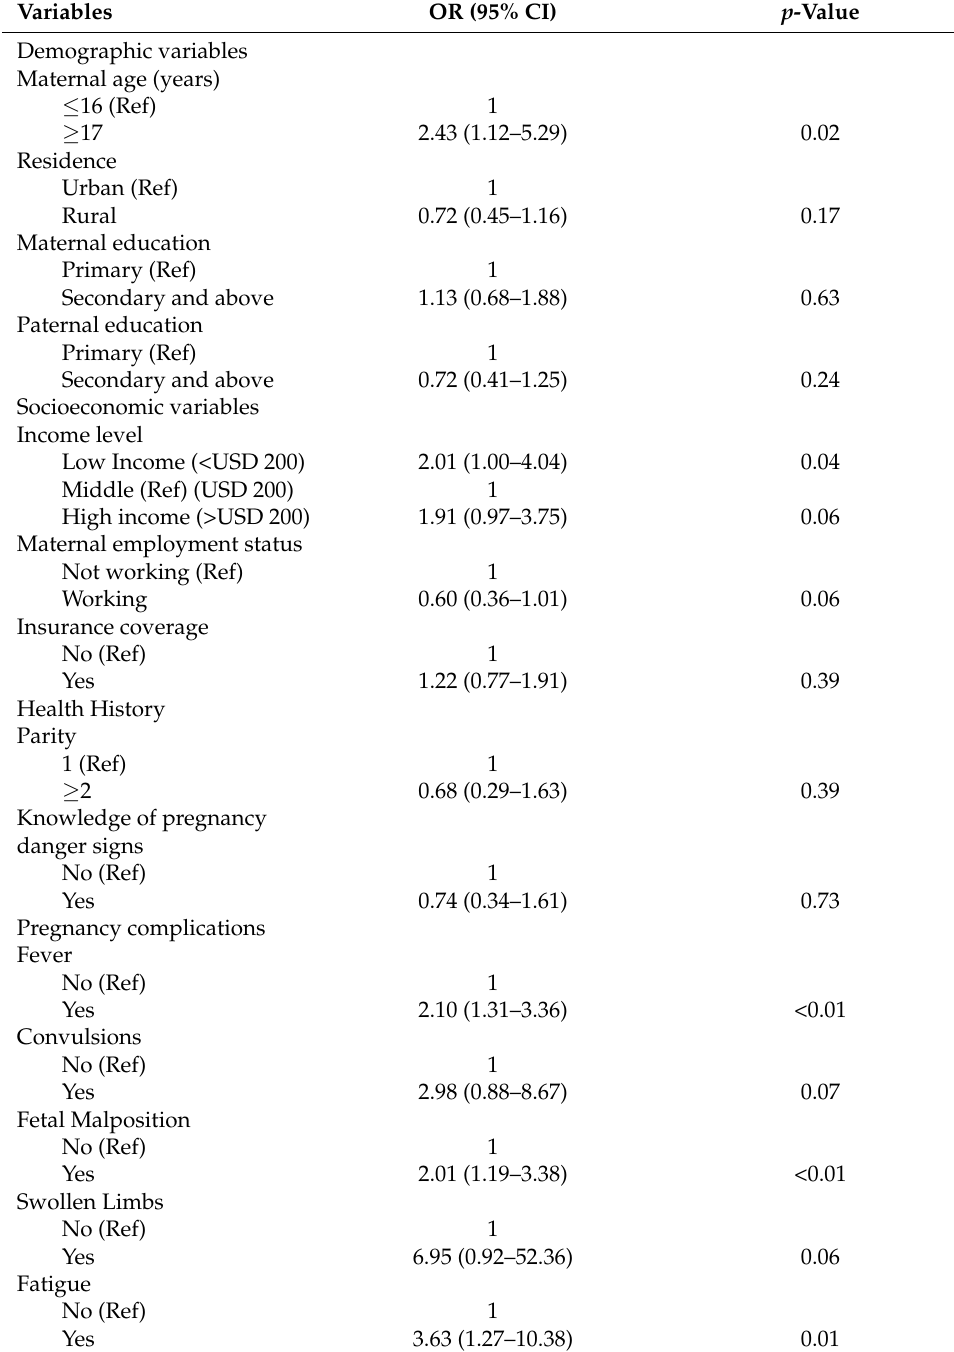
Table 2. Independent variables with relation to use of antenatal